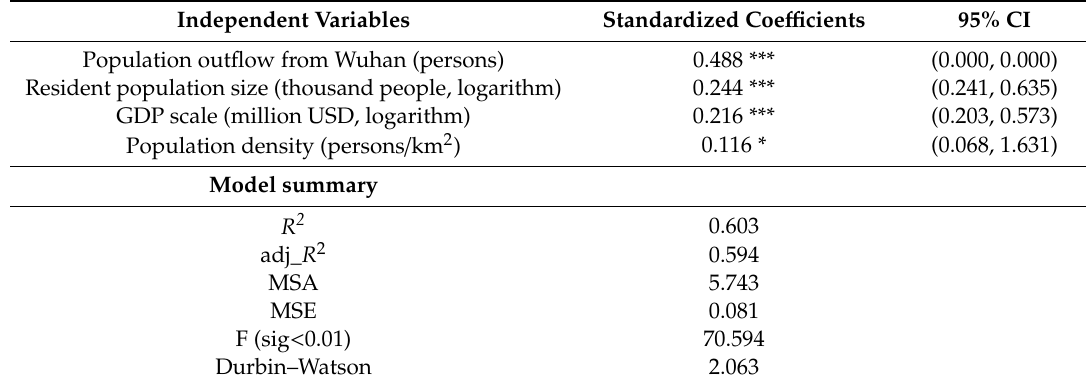
Table 3. Association between cumulative confirmed COVID-19 cases and other socioeconomic variables according to multivariate regression